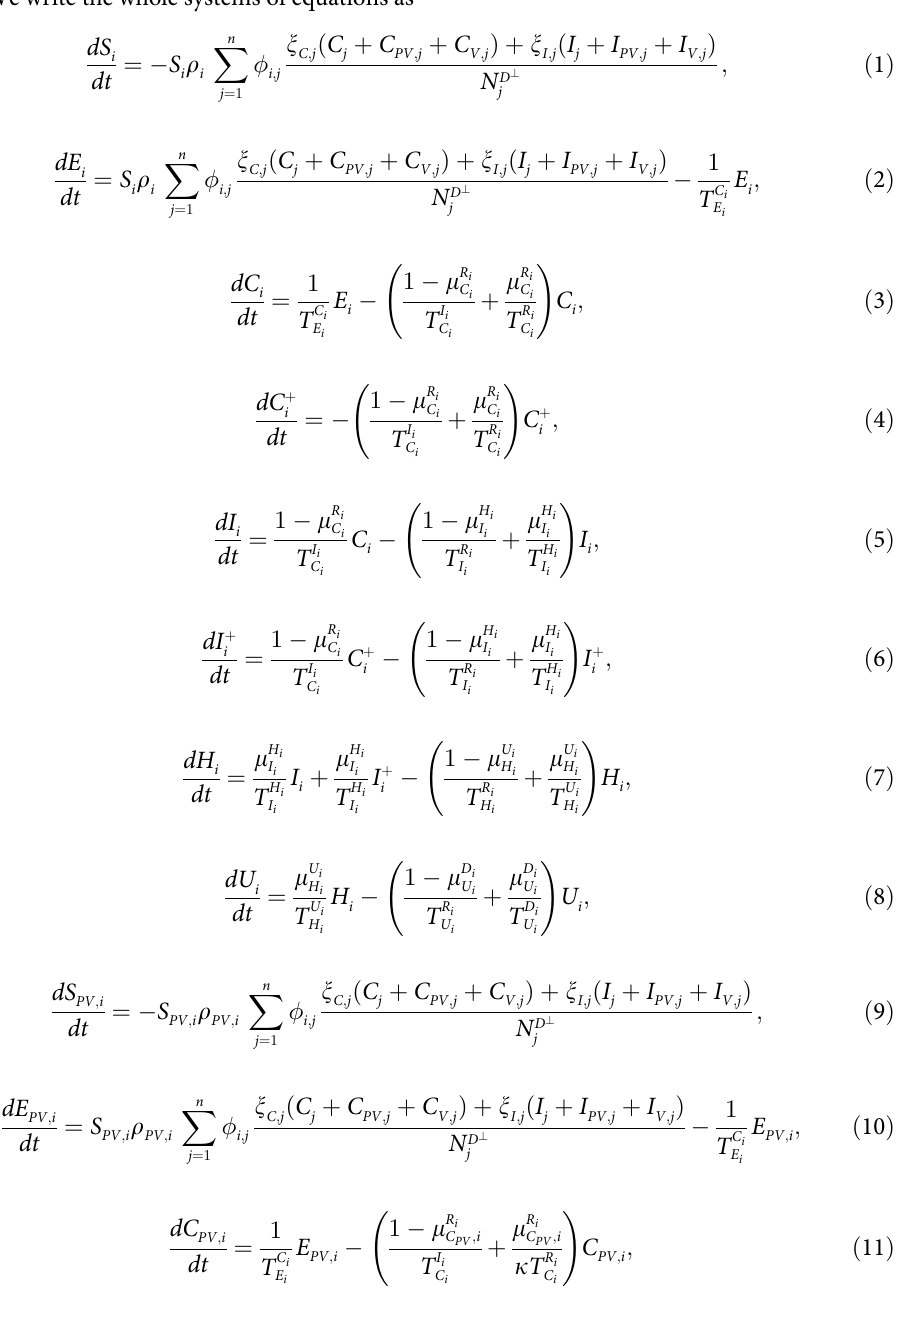
Fig 1. To resolve age-specific disease parameters, we divide the totality of people N into i = 1, . . . , n = 6 different age groups as defined in Table 1. Thus, all of our compartments have an age-dependence that we indicate by the subscript i . We define Z all compartments of age group i and N D ? group